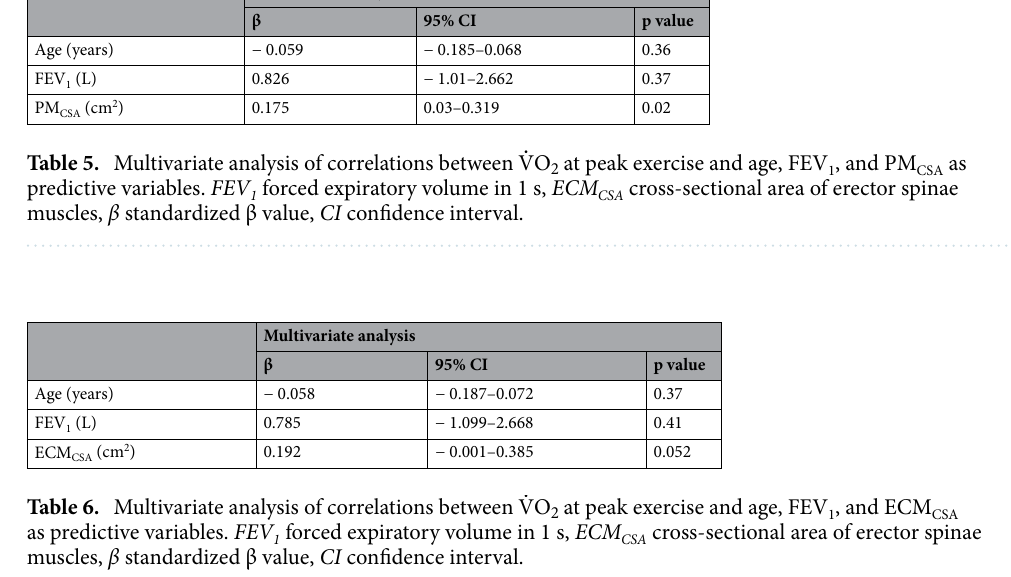
˙ VO Figure 2. Results of 2 by ( a ) GOLD stage and ( b ) mMRC dyspnea scale score. *p < 0.05. GOLD Global Initiative for Chronic Obstructive Lung Disease, mMRC modified Medical Research Council.